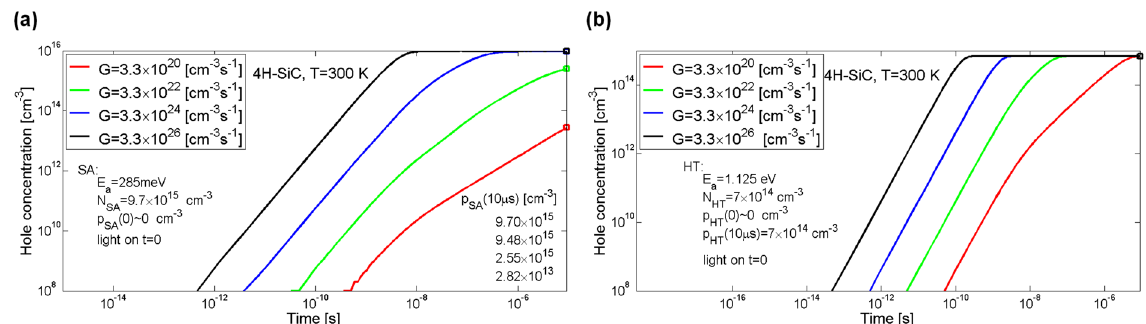
Figure 8. Simulation of the temporal changes in hole concentration at trap levels of the shallow acceptors SA ( a ) and of the deep hole trap HT ( b ) in 4H-SiC material. Parameter G is the generation rate